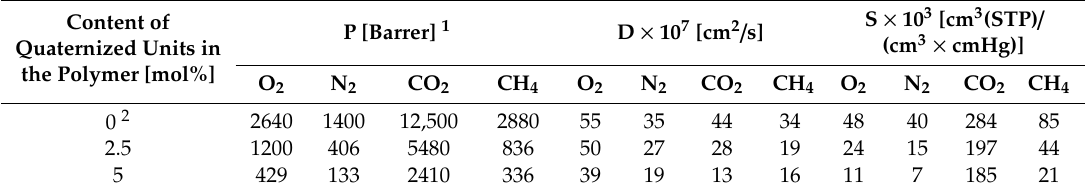
Table 4. Gas permeability, solubility and di ff usion coe ffi cients of membranes containing butylimidazole salt in the polymer matrix.